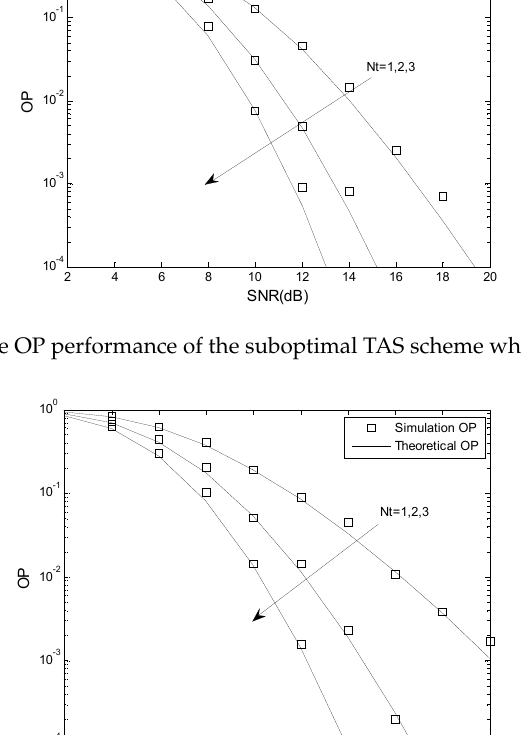
Figure 6. The OP performance of the suboptimal TAS scheme when γ th < γ P .